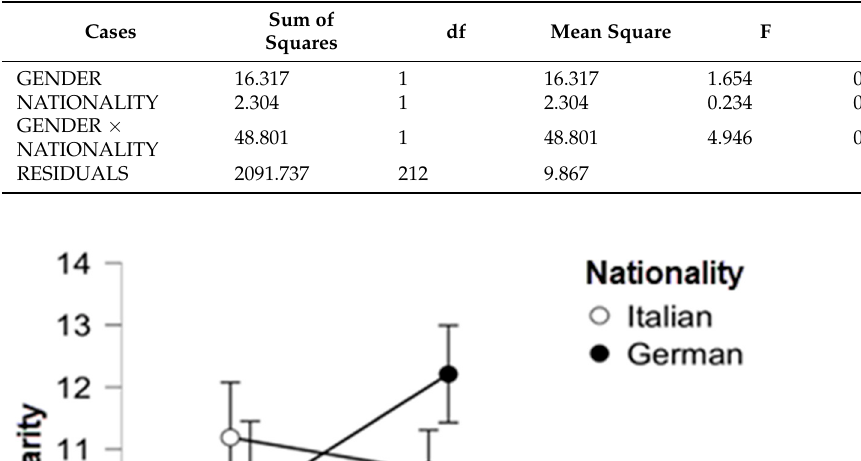
Table 7. Post Hoc Comparisons of gender respondents in the zoos. The p -value was adjusted for comparing a family of four using Tukey’s correction .